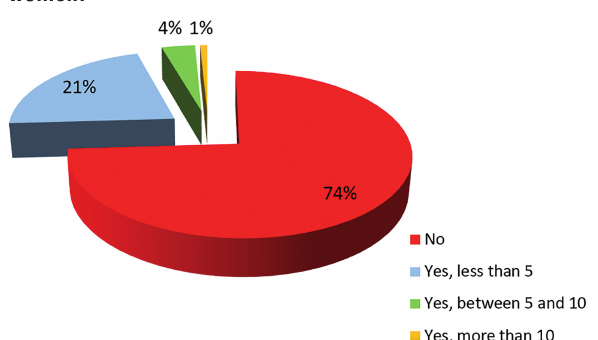
Figure 3 - Result of the monthly sexual intercourse of